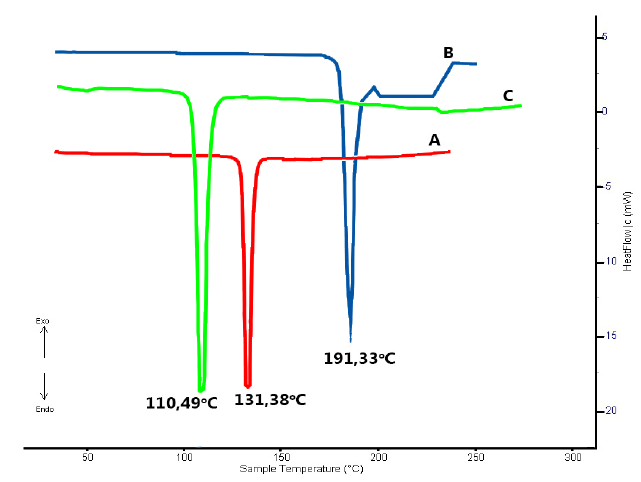
Figure 2. Differential scanning calorimetry thermogram of (A) piperine, (B) succinic acid, and (C) the cocrystal of piperine–succinic acid (2:1 molar ratio).